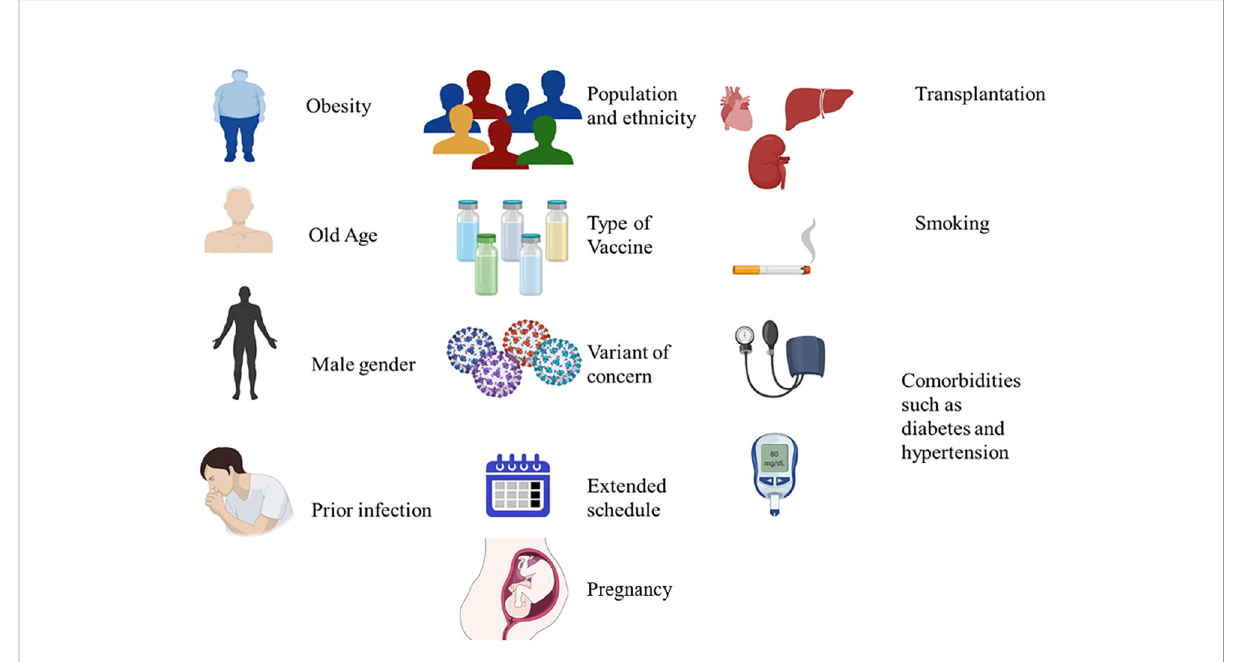
FIGURE 1 Factors affecting the effectiveness of the